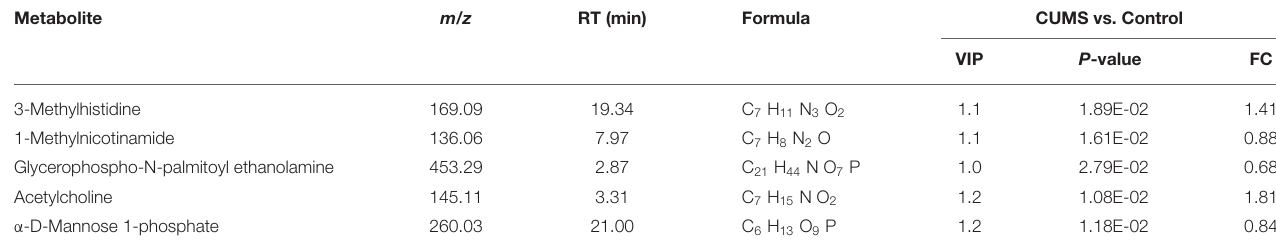
TABLE 1 | Differential metabolites in CUMS